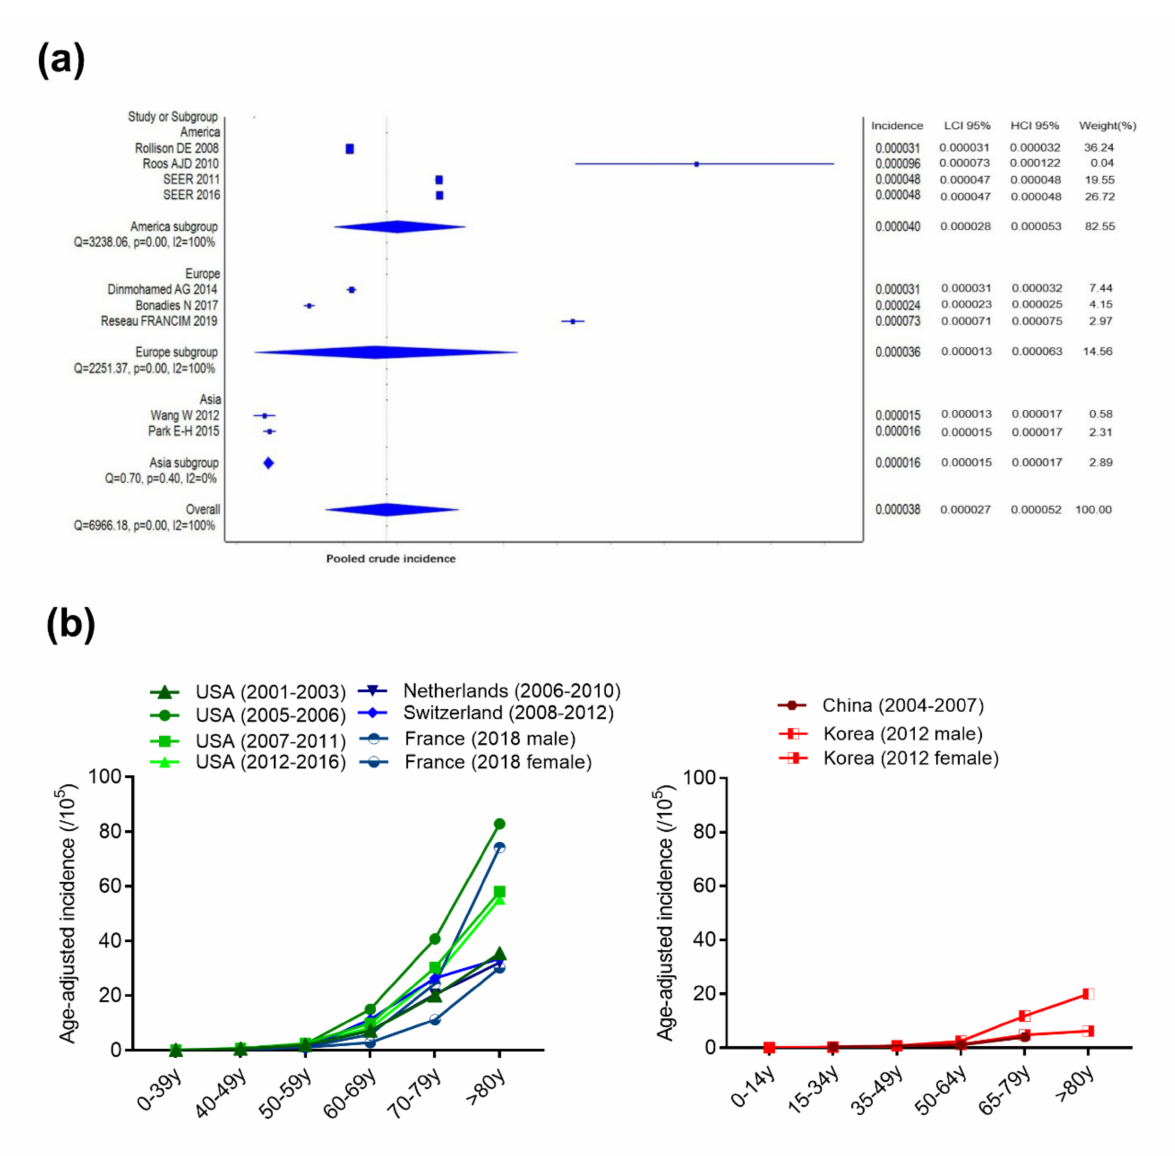
Figure 2. Epidemiological characteristics of MDS in Western and Asian countries. ( a ) Pooled crude incidence in America, Europe, and Asia. ( b ) Age-adjusted incidence in Western and Asian countries. Figure 2 has been drawn based on the data and publications [10–19] described in Supplemental Table